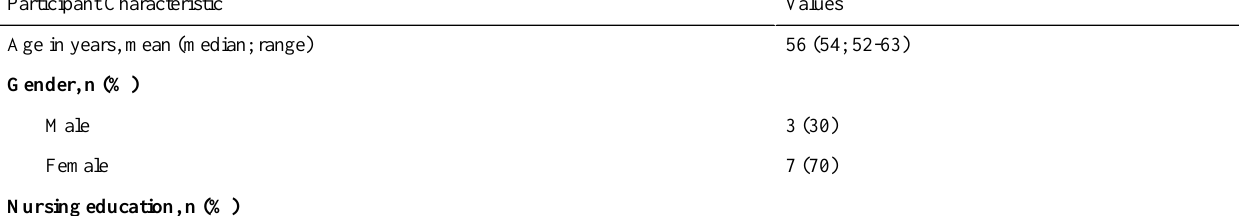
Table 3. Characteristics of participants (N=10). ValuesParticipant